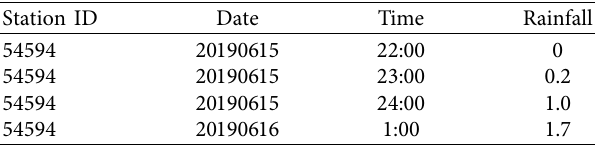
Table 2: Rainfall data